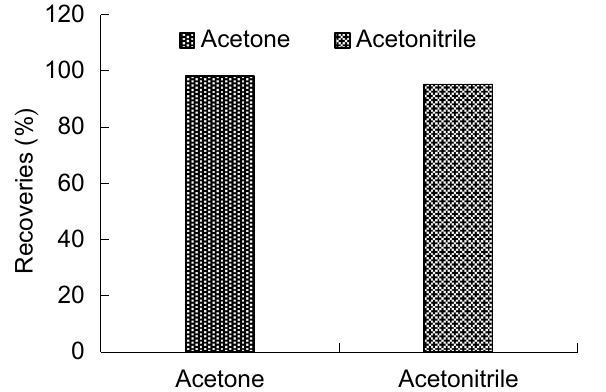
Figure 7. Recoveries of different type of dispersant.